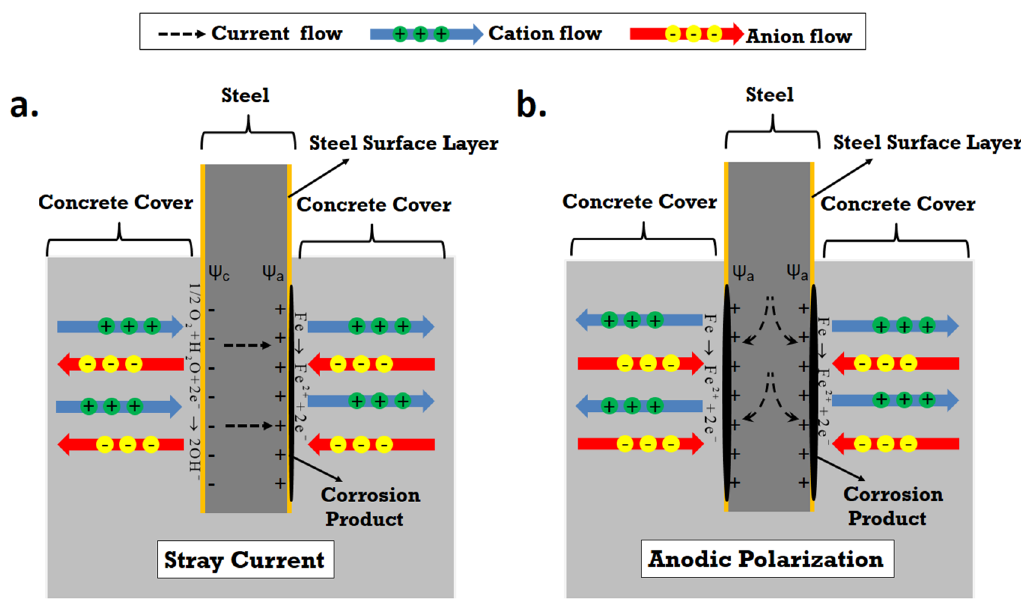
Figure 1. Ion migration in reinforced concrete undergoing: ( a ) Stray current; ( b ) Anodic polarization.